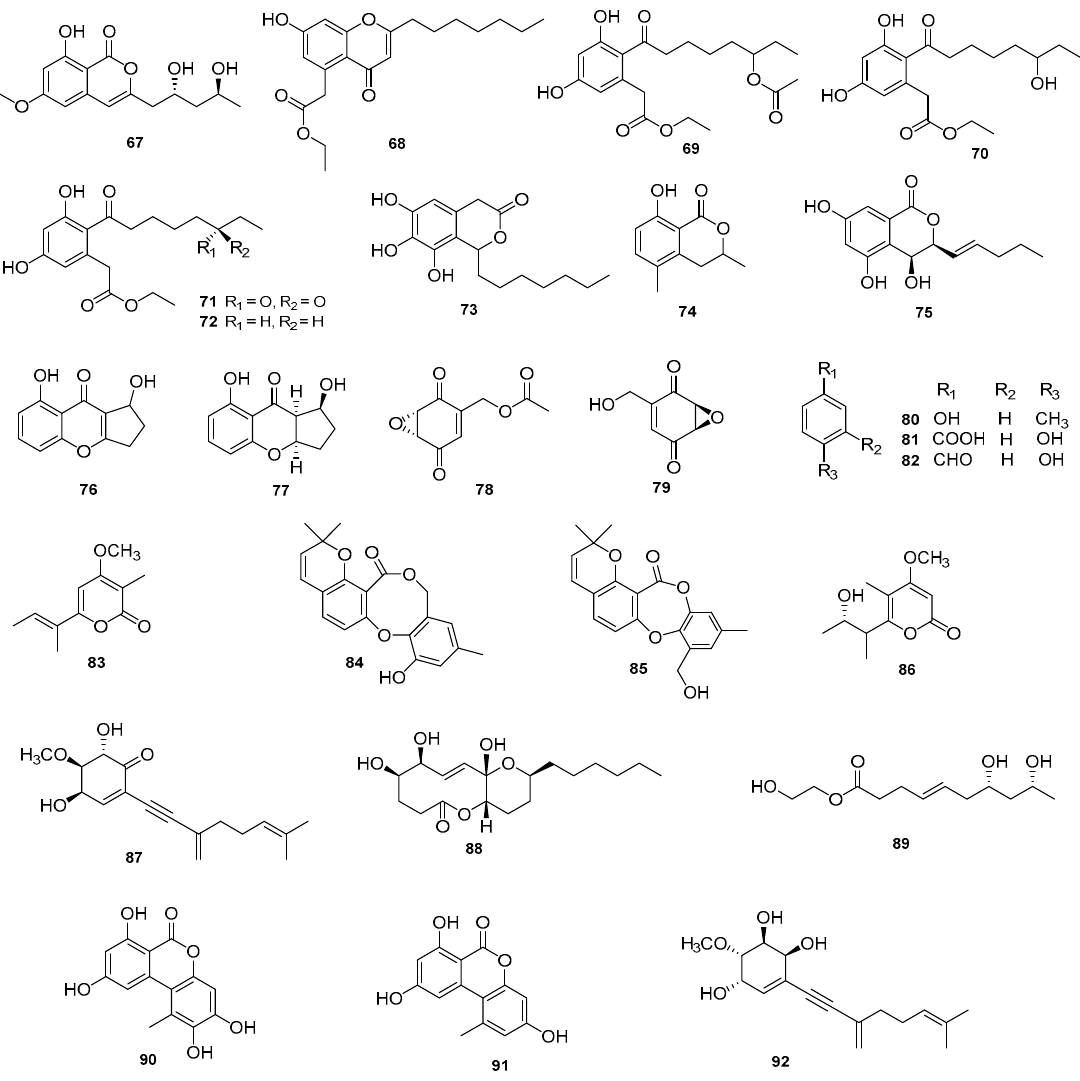
Figure 4. Chemical structures of compounds 67 – 92 of terrestrial origin.